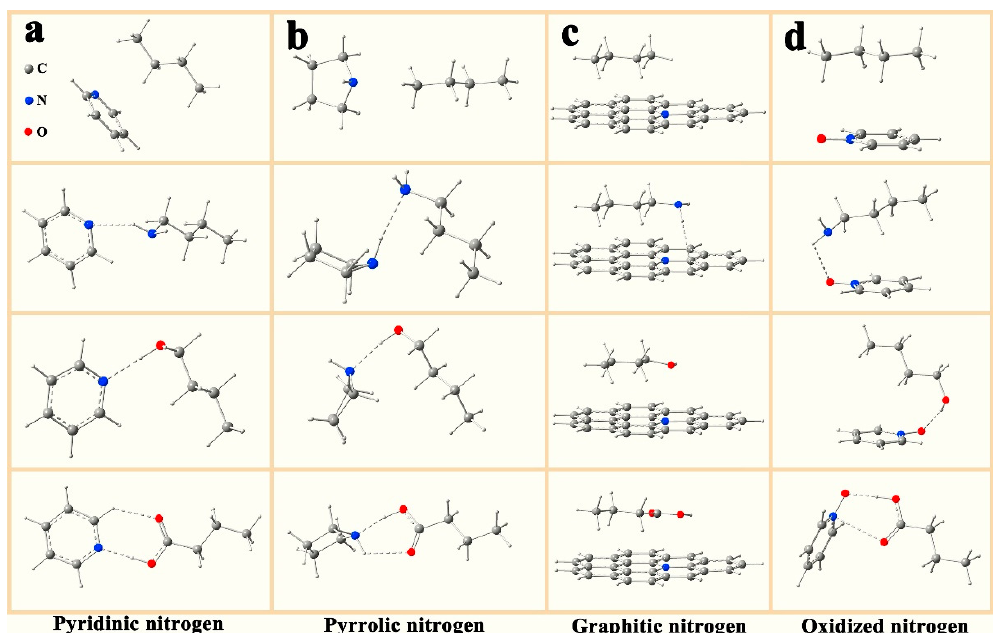
Figure 3. Optimized organic bimolecular configurations between different nitrogen species of N-doped hierarchical carbon and PCM molecules with different functional groups such as ( a ) Pyridinic nitrogen, ( b ) Pyrrolic nitrogen, ( c ) Graphitic nitrogen, and ( d ) Oxidized nitrogen (reproduced with permission [59]).